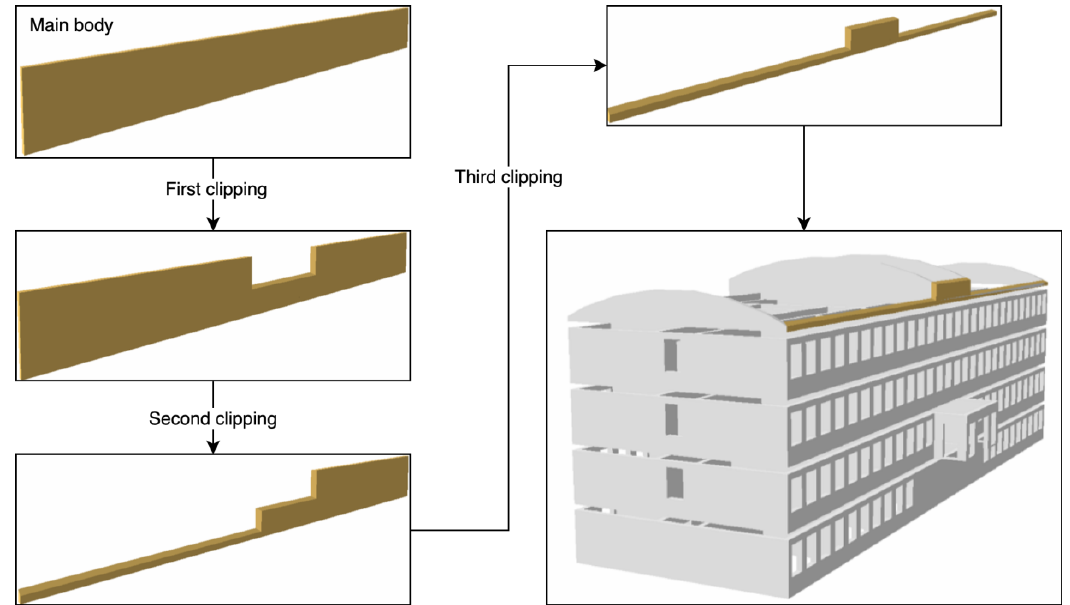
Figure 10. Generating a wall entity (ID 228278) for the Institute model.